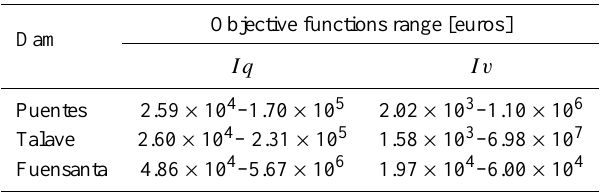
Table 4. Range of objective functions ( Iq and Iv ) values for the Pareto